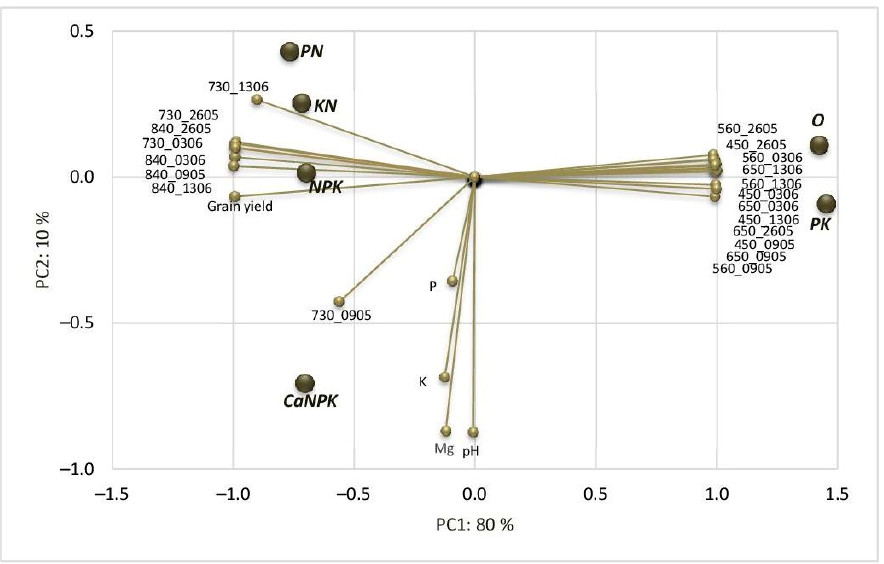
Figure 4. Results of principal component analysis presenting multivariate differences between the treatments of winter rye in experiment 1 (crop rotation).